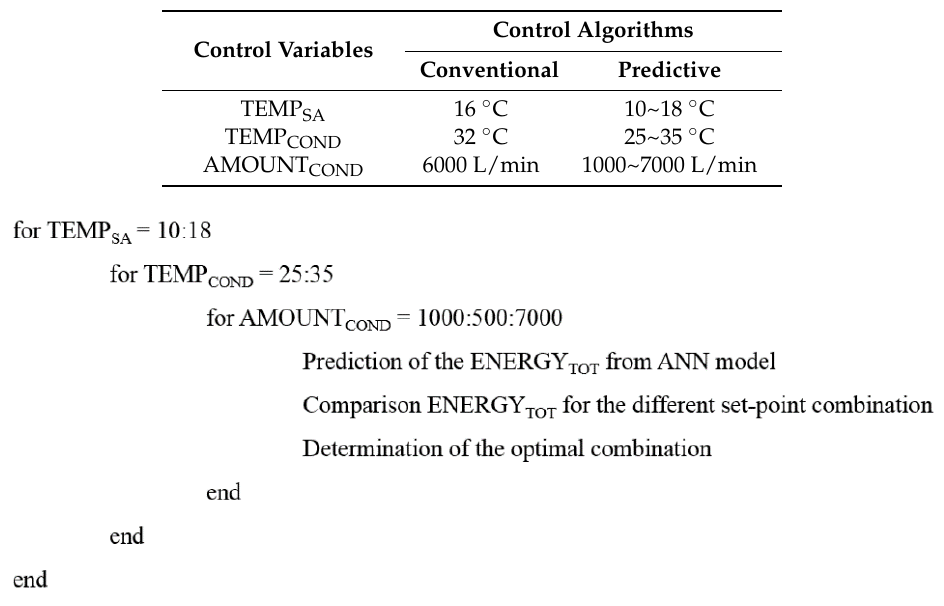
Table 2. Set-points of the control variables in the conventional and predictive control algorithm.